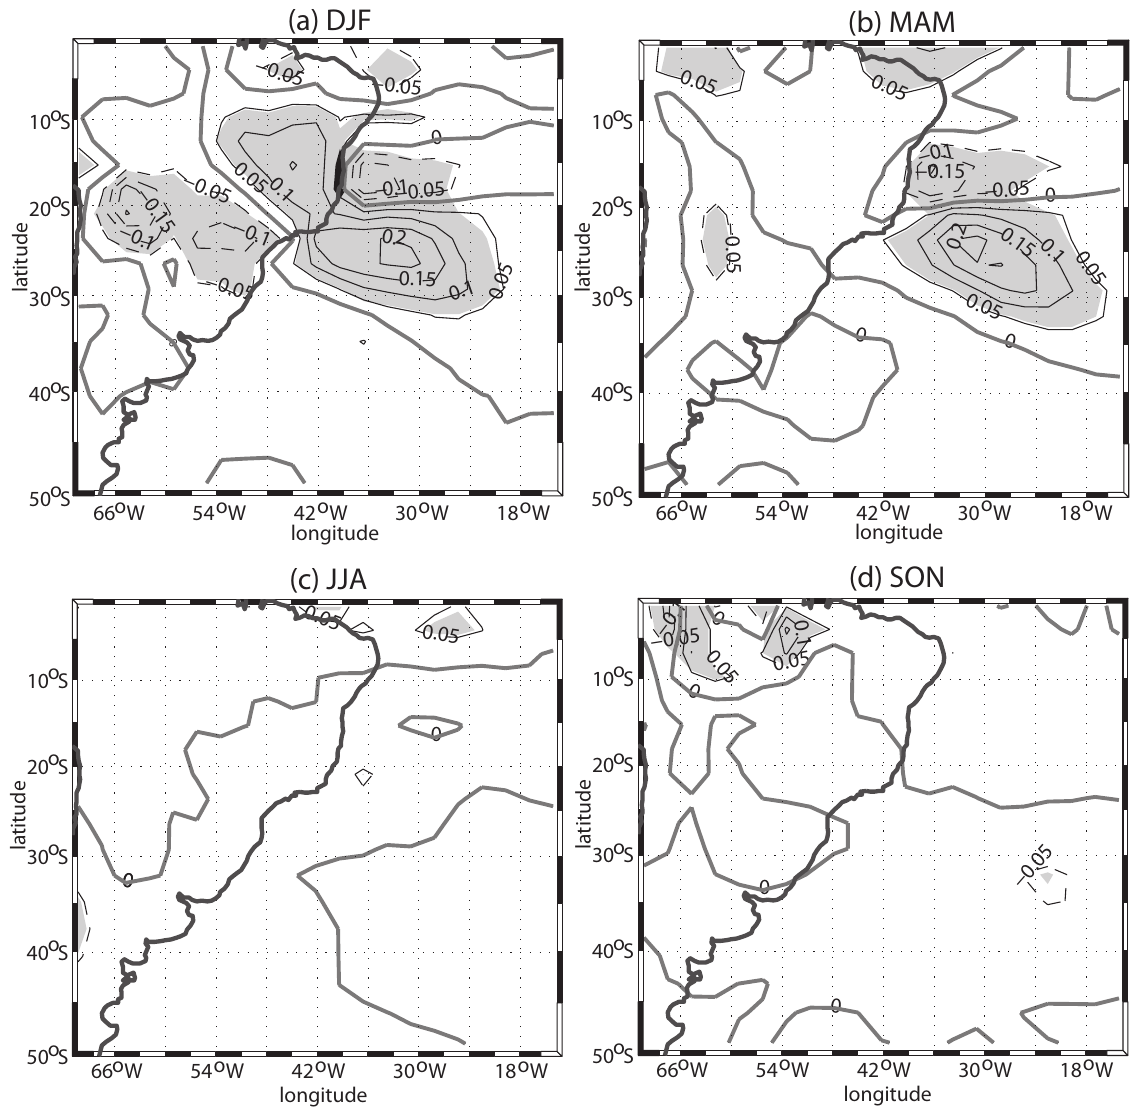
Fig. 8. Precipitation anomaly from EXP2 regressed onto the Ni˜no3 Index. Contour interval is 0.25. Units in mmday − 1 . (a) DJF, (b) MAM, (c) JJA and (d)